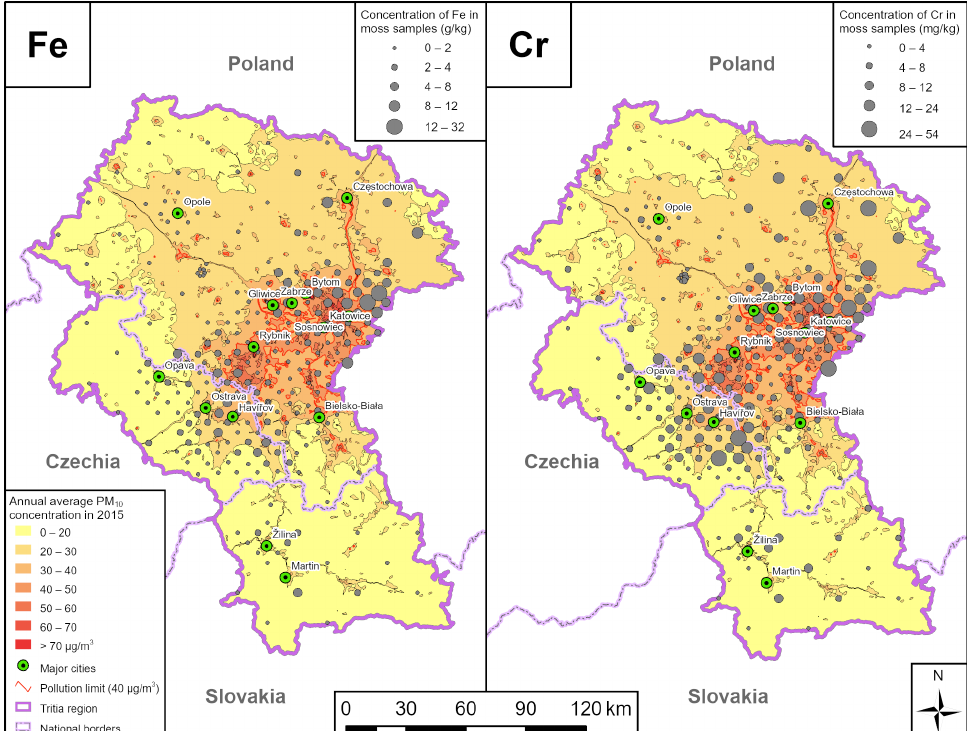
Figure 7. Fe and Cr concentrations determined by INAA in mosses and ADMOSS results comparison.